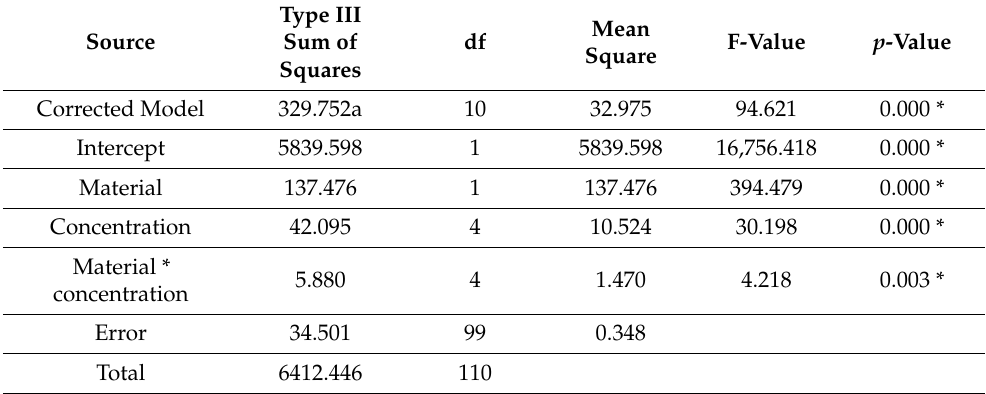
Table 6. Two-way ANOVA results for the combined effects of materials and concentration